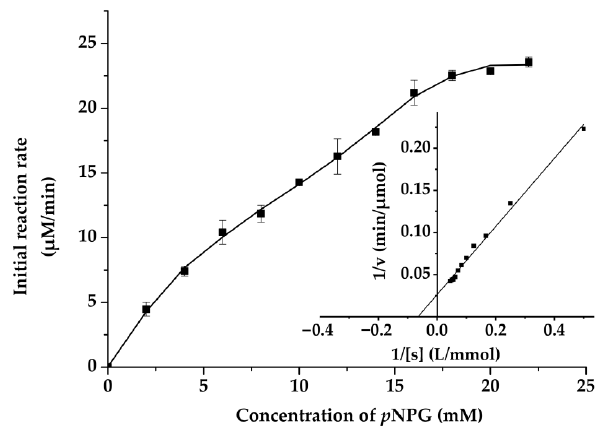
Figure 8. Michaelis-Menten plots for the reactions with pNPG. The inset shows the Lineweaver-Burk plots. Each data point represents the mean ± SD of three independent experiments.